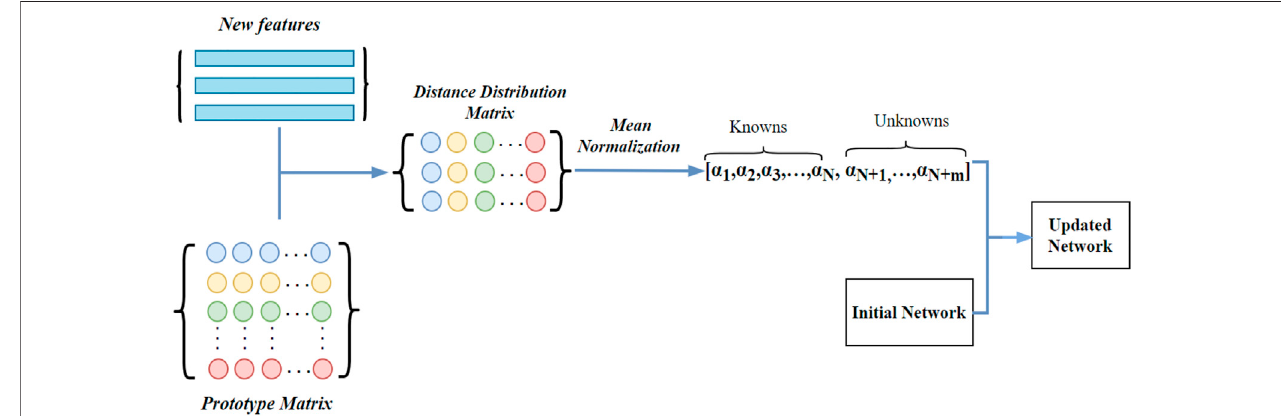
FIGURE 6 | Network updater module.